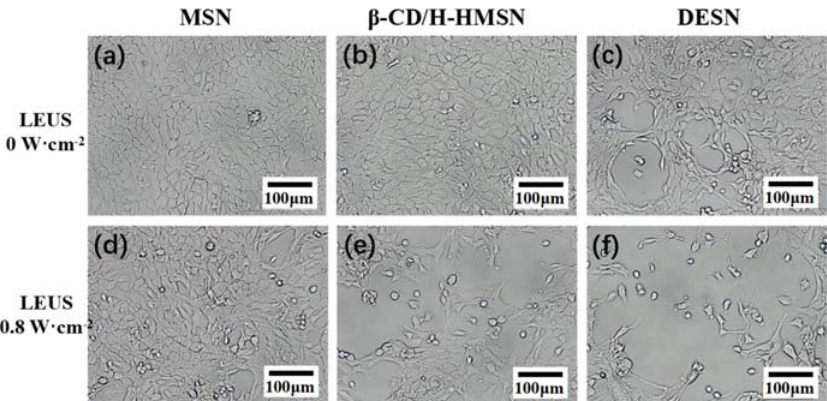
Figure 7. Microscopy images of 4T1 cells with no LEUS irradiation after co-culture with MSN ( a ); FA- β -CD/H-MSN ( b ) and DESN ( c ), respectively. Compared with the MSN group and FA- β -CD/H-MSN group, the morphology of the 4T1 cells in the DESN group slightly changed, which indicated low cytotoxicity. Microscopy images of 4T1 cells with LEUS irradiation (1 MHz, 0.8 W·cm − 2 ) after co-culture with MSN ( d ); FA- β -CD/H-MSN ( e ) and DESN ( f ), respectively. Compared with those groups without LEUS, after nanoparticle incubation with DESN and exposure to LEUS irradiation (0.8 W·cm − 2 ), the morphology of cells and population changed. However, after incubation with DESN and exposure to LEUS irradiation (0.8 W · cm − 2 ), an obviously reduced cell population and changed cell morphology could be